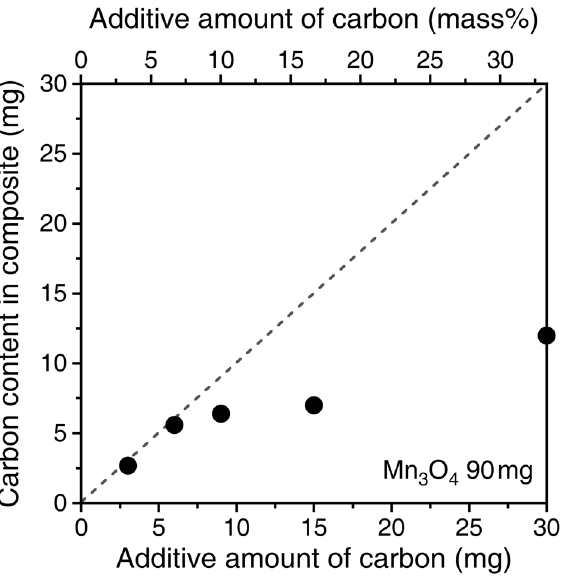
Figure 3. Retained amount of carbon nanoparticles compared to the added